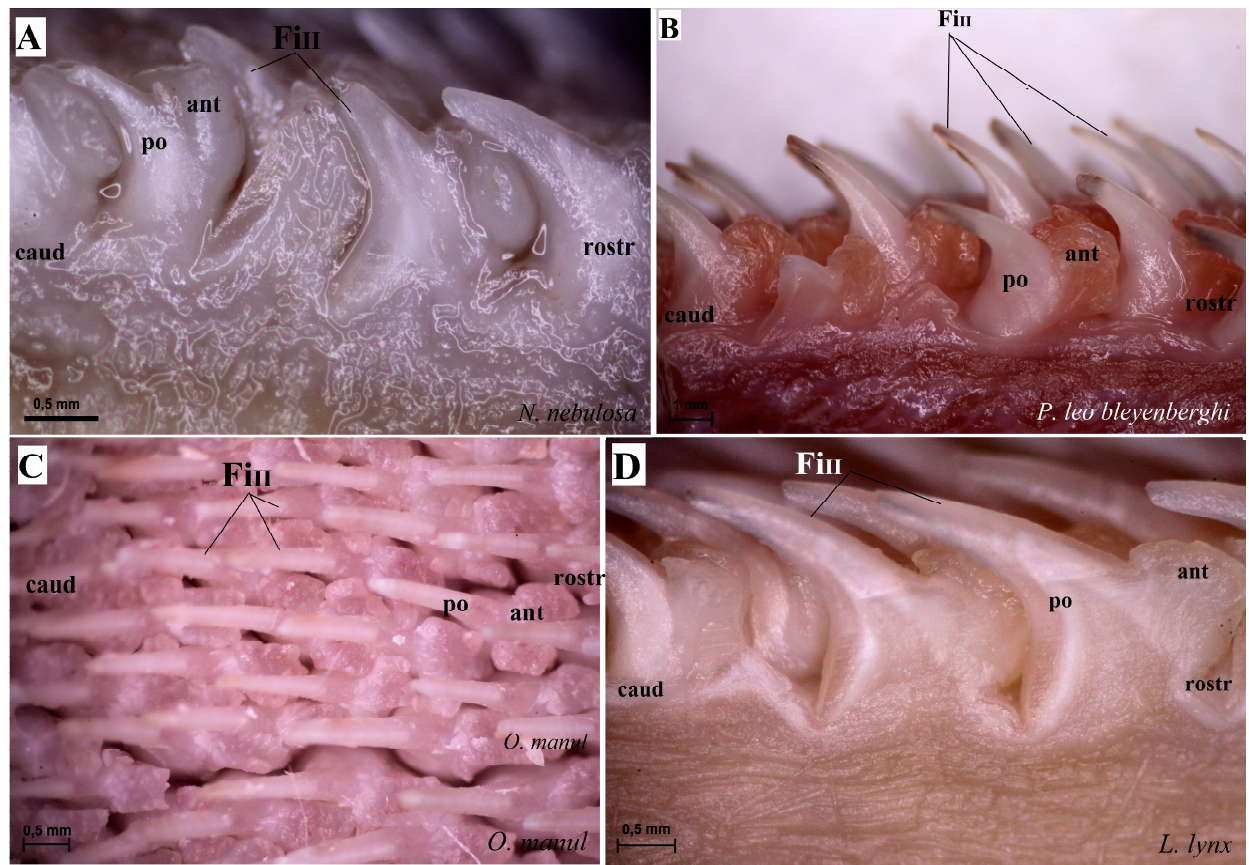
Figure 3. Stereoscopic view of the mechanical lingual papillae from dorsal surface of the rostral part of the tongue of four species of wild Felidae: N. nebulosa ( A ), P. leo bleyenberghi ( B ), O. manul ( C ) and L. lynx ( D ). Bar = 0.5 mm (A–C,D); bar = 1 mm (B). Abbreviations: ant — anterior part of the